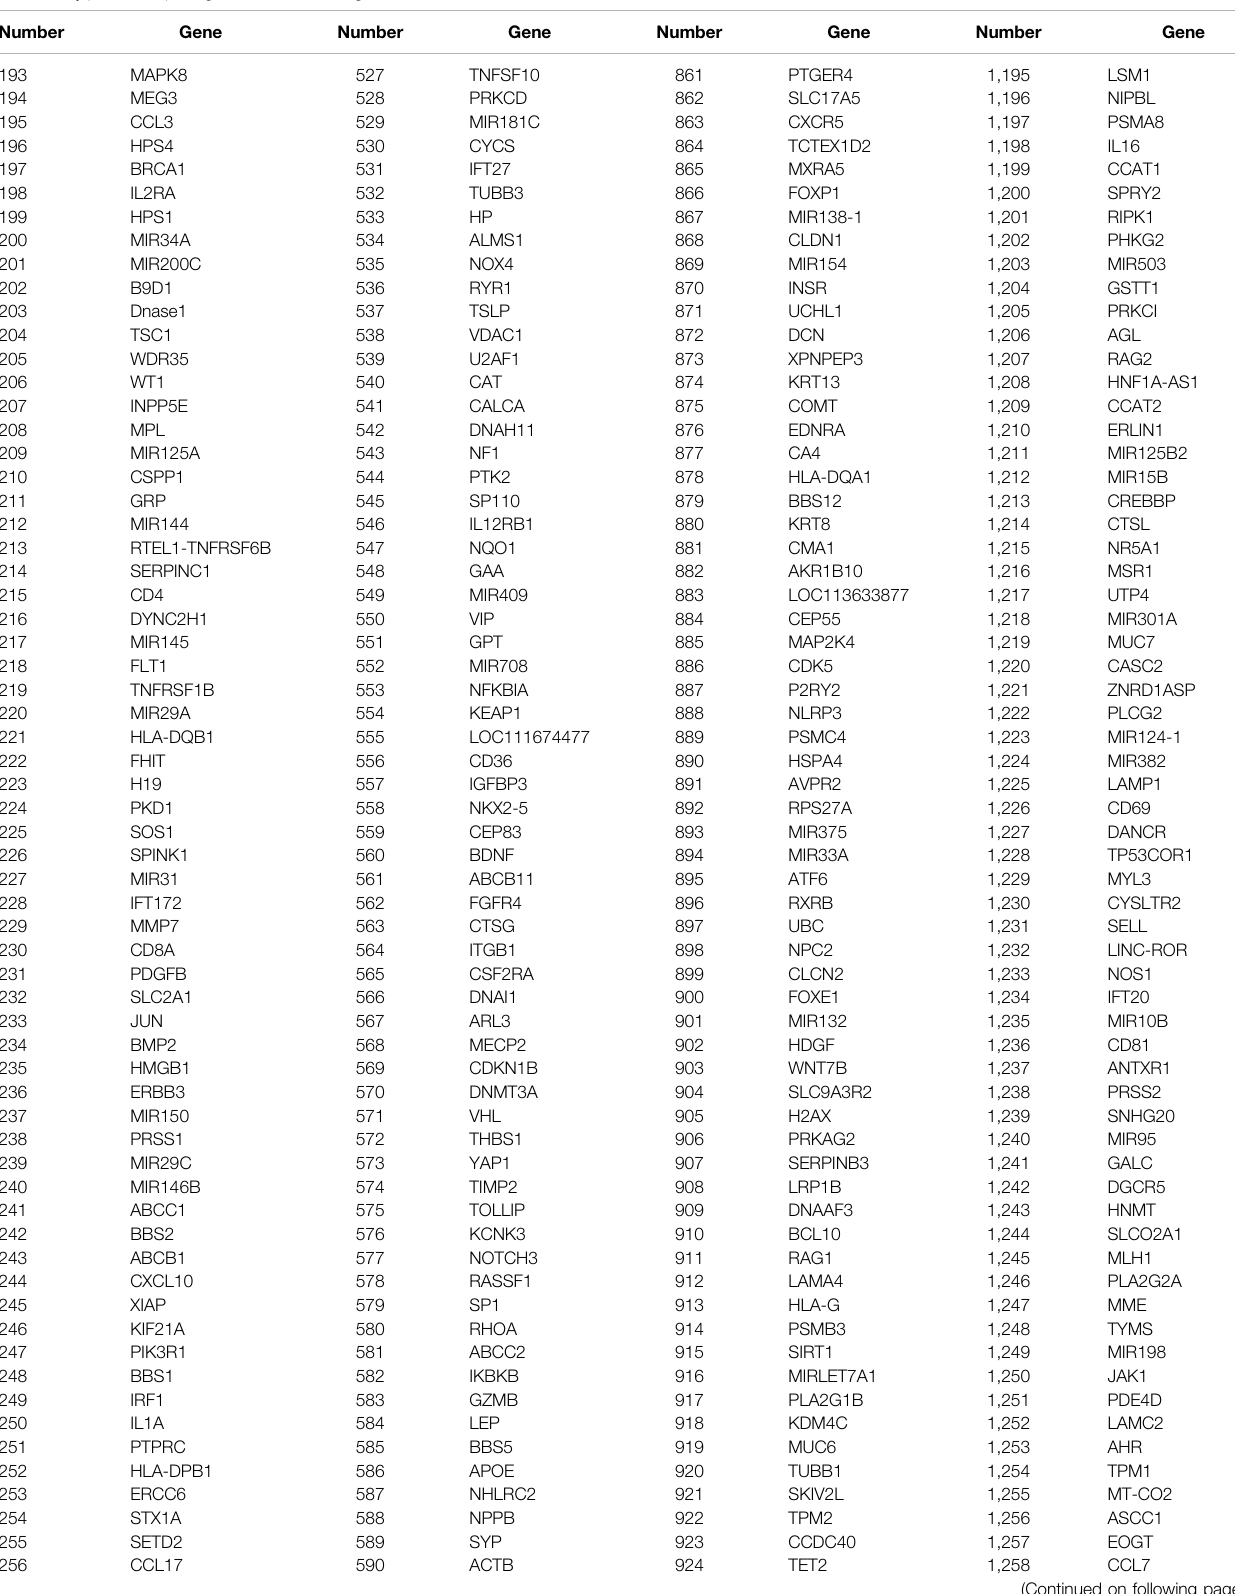
TABLE 3 | ( Continued ) Lung fi brosis-related targets obtained from the GeneCards